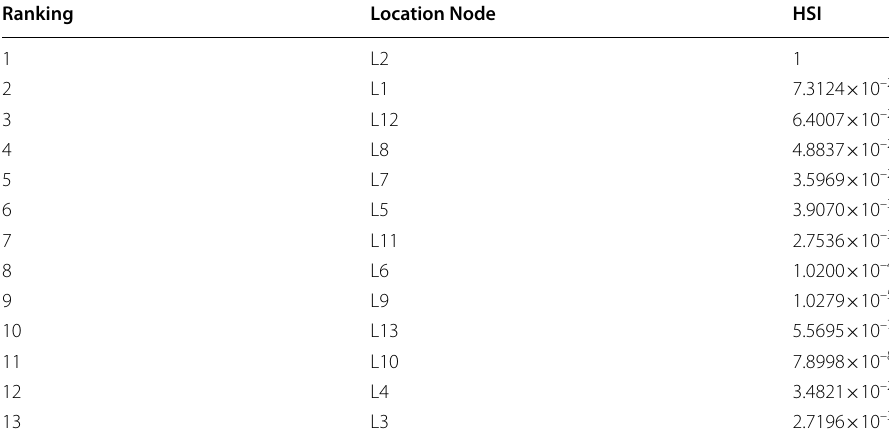
Table 4 Ranking of location nodes (Source: Liew et al. 2015a p. 273)